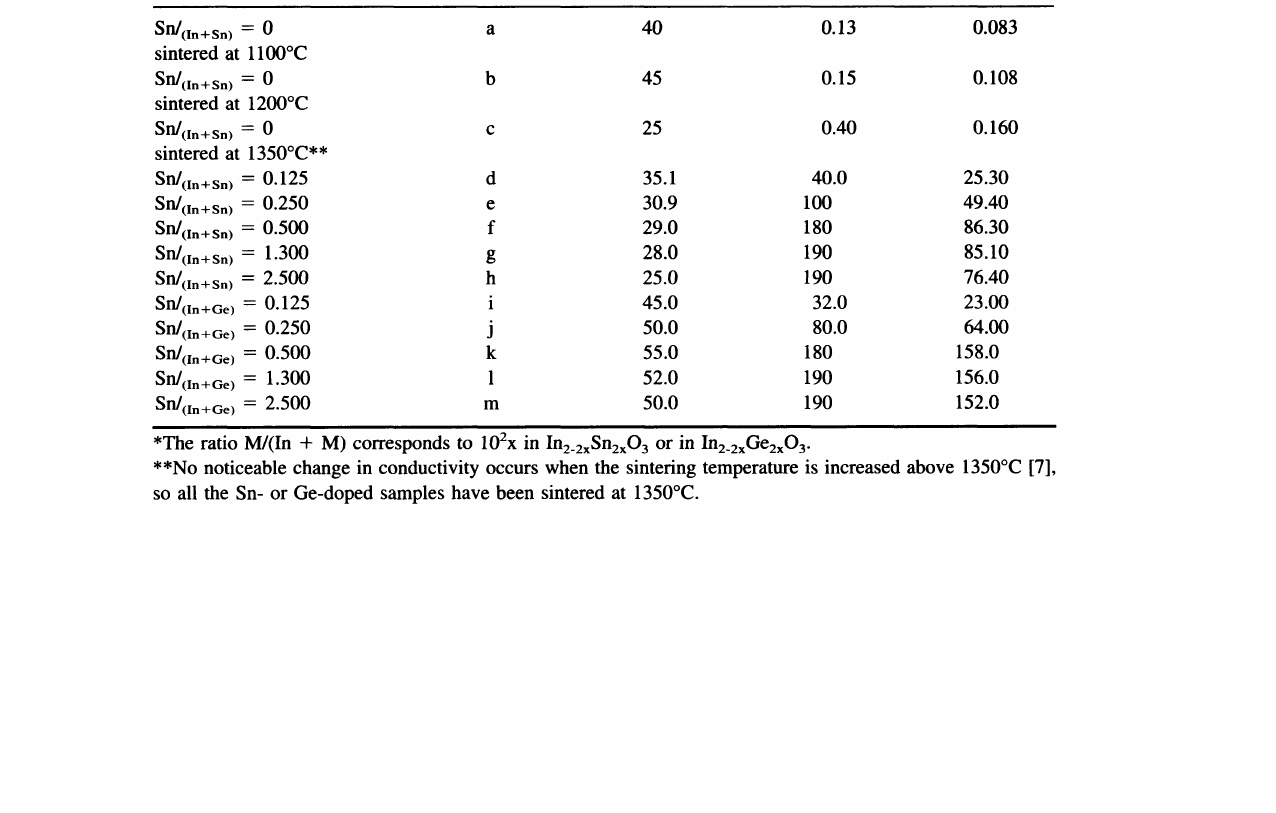
Values of the carder mobility, carder concentration and room temperature conductivity for the undoped (samples a---c) and Sn- or Ge-doped In203 (samples dram) ceramics [3]. M/On+M ratio* Sample M Sn or Ge (% values)